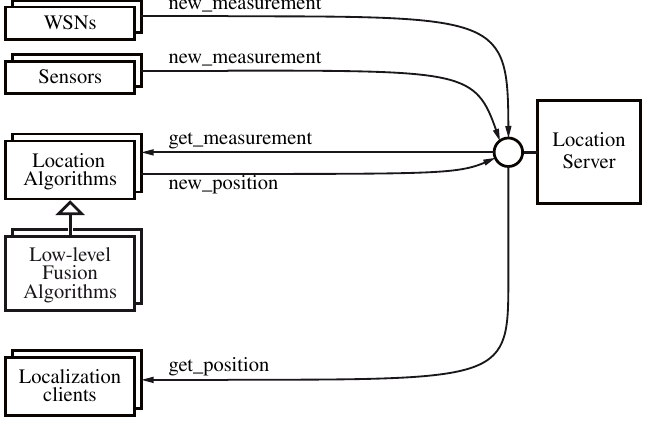
Figure 4. Once the network infrastructure is registered, and the location algorithms and clients configured, these actors continuously use the same type of messages to save and retrieve data with the